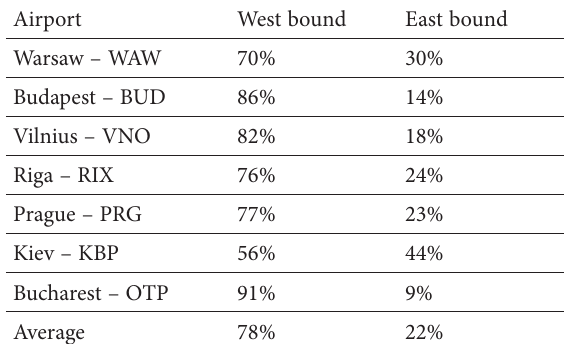
Table 2. Share of routes to the East and West Airport